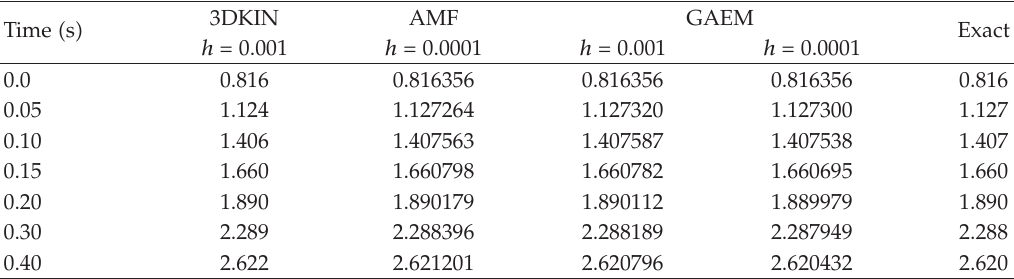
Table 2. The results of the GAEM for the two energy groups of the point kinetics